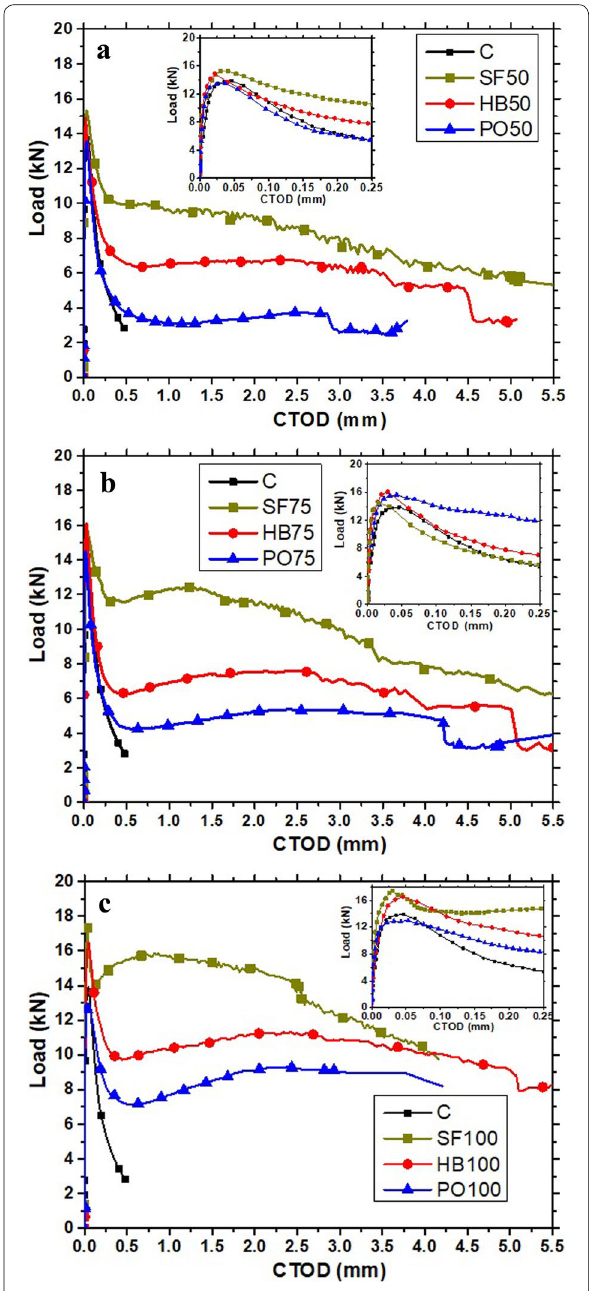
Fig. 4 Effect of fibre types on load vs. CTOD graphs of same fibre dosage: a 0.50% Vf; b 0.75% Vf; c 1.00%